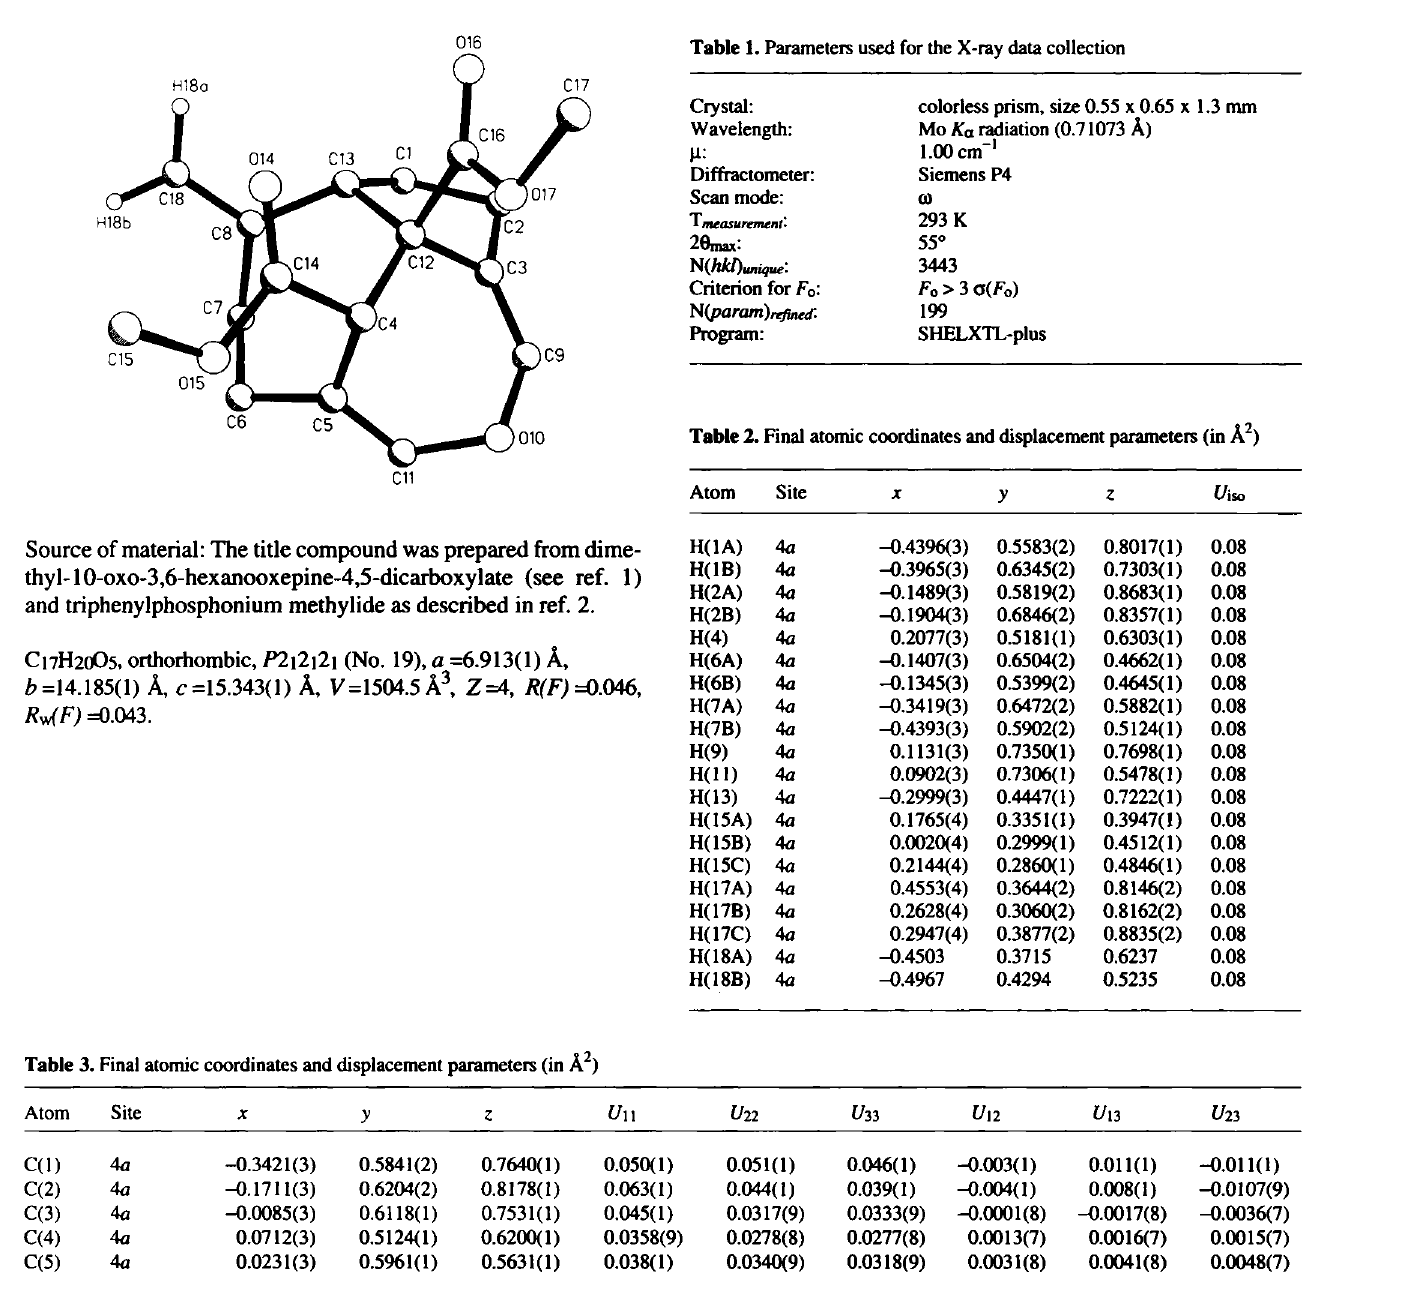
Table 1. Parameters used for the X-ray data collection